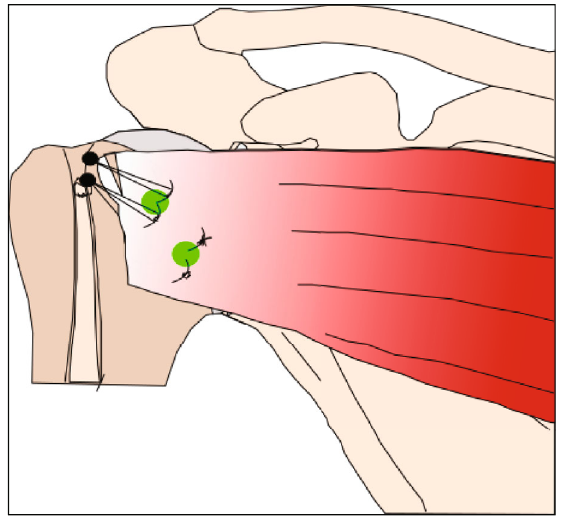
Figure 3: Operative